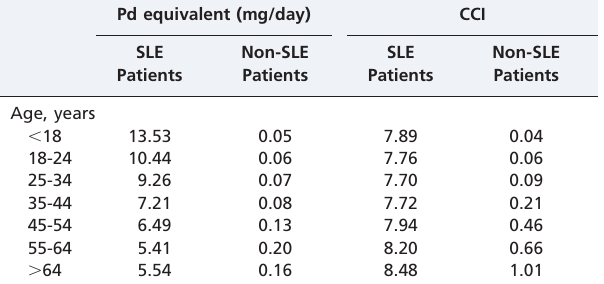
Table 4 - Incidence rates (number of cases per 1000 patient-years) of herpes zoster in the SLE patients